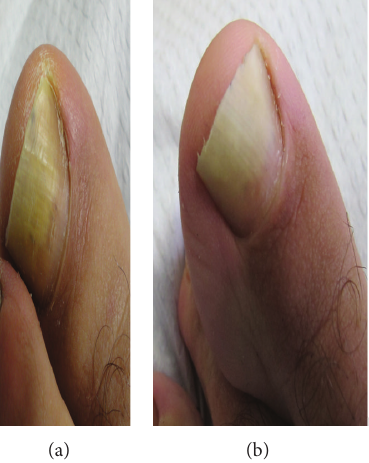
Figure 7: (a) 58-year-old male patient, before treatment. Trichophyton rubrum was isolated on mycological testing. OSI was 30. (b) After treatment with great improvement. OSI is 9 showing 70.00%